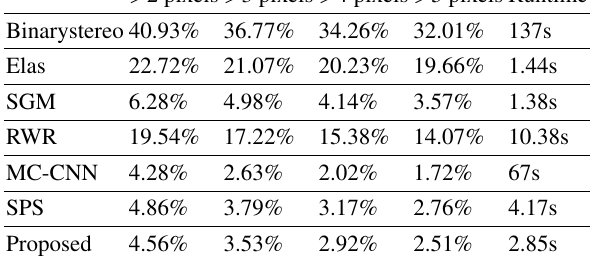
Table 4. Comparison with the mainstream methods on the test set of